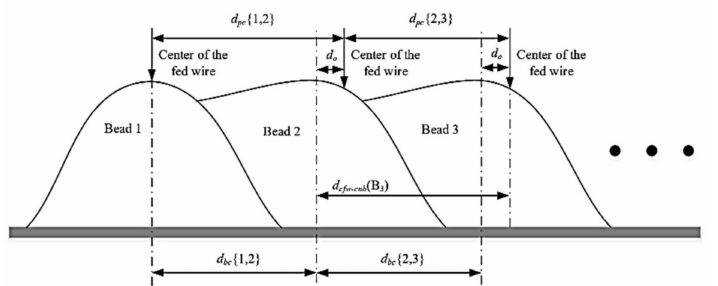
Figure 39. Enhanced bead overlapping model Reprinted with permission from Ref. [80]. Copyright 2018